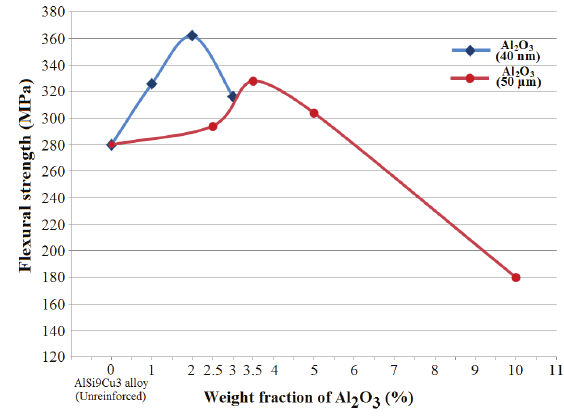
Figure 7: SEM image of fracture surface of AMMNC sample having Cu 9 3 3wt.% nano-sized Al O 2 3